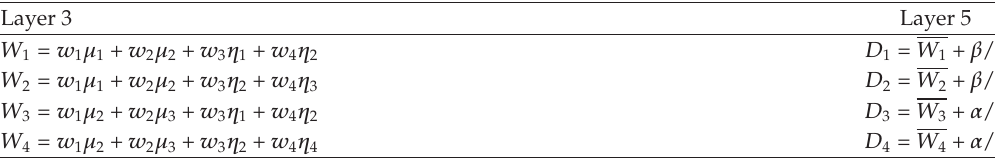
Table 1: Rules for